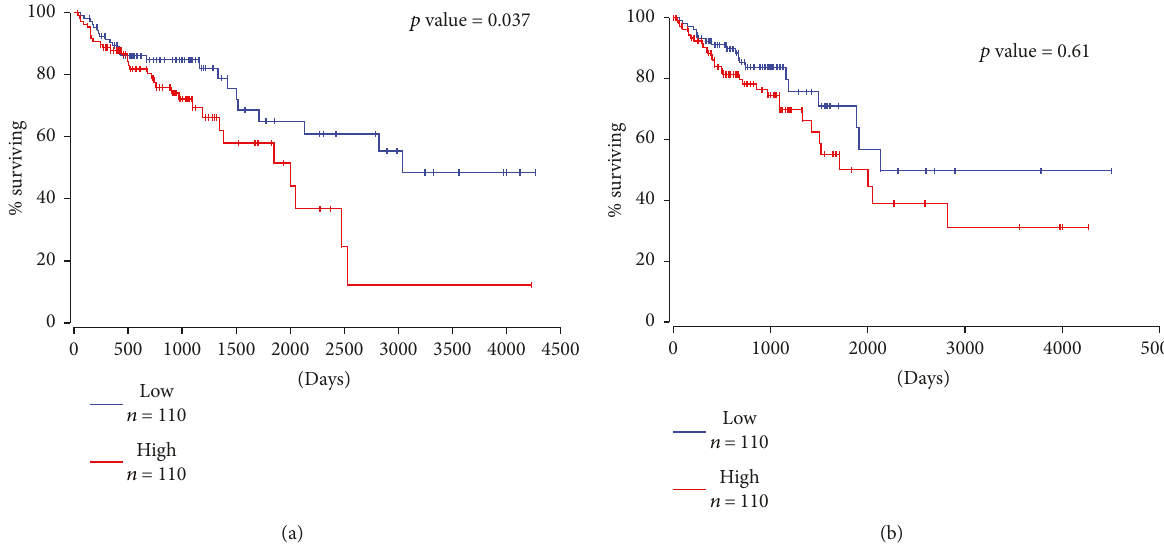
Figure 7: Overall survival analysis for HOXA4 and HOXD10 in colorectal cancer. Kaplan-Meier survival analysis of the 220 colorectal cancer patients using TCGA dataset. (a) HOXD10 and (b) HOXA4 survival analysis was performed for CRC patients with a cuto ff value of 25th percentile. Credits: